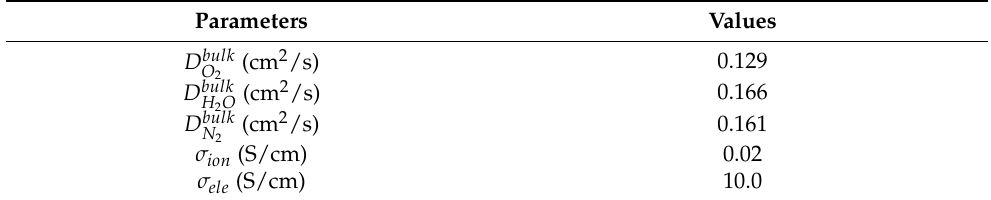
Table 1. Transport parameters used in the model